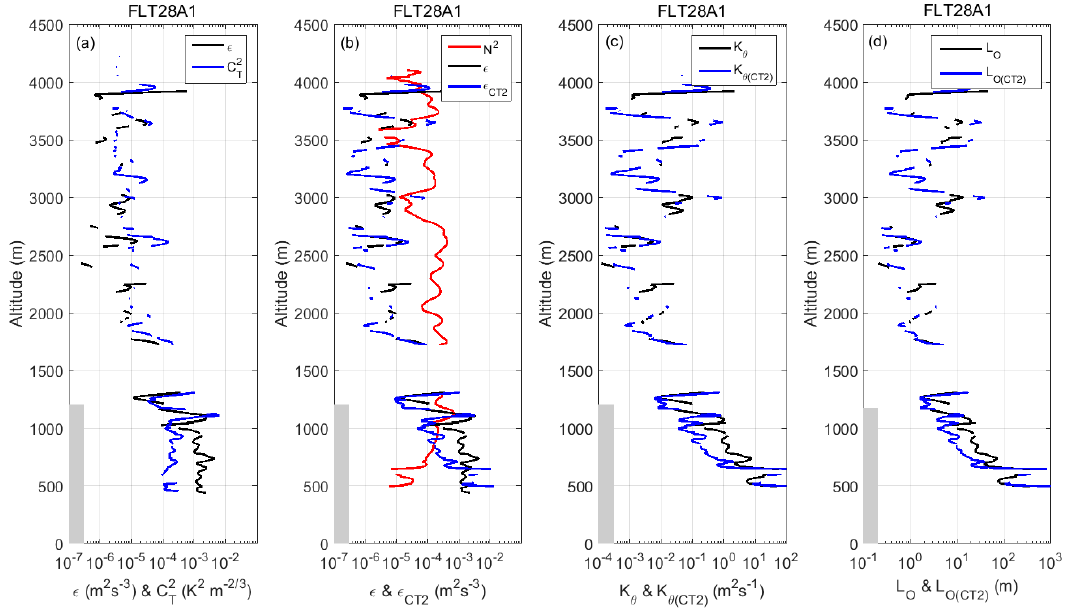
Figure 10. The same as Figure 9 for FLT28A1. The gray shaded areas show the CBL depth.